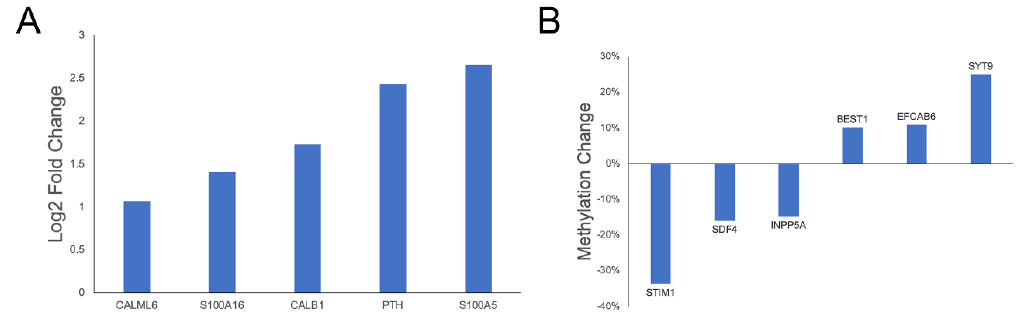
Figure 7. DEGs and genes overlapping DMRs related to calcium transport and binding. Log2 fold changes and percent methylation changes of ( A ) DEGs and ( B ) genes overlapping DMRs related to calcium transport and binding.